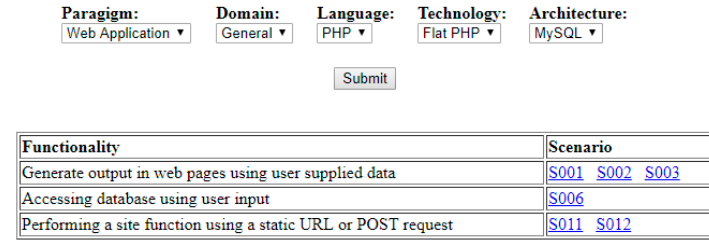
Figure 11. The user interfaces for context selection.